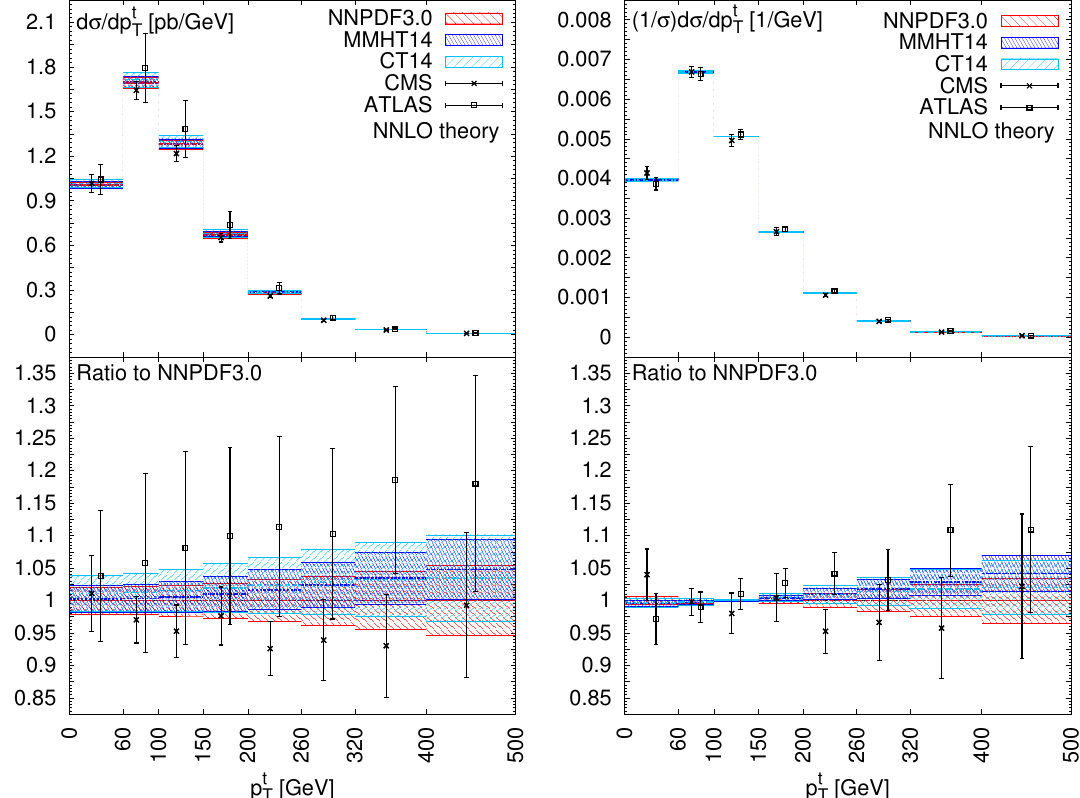
Figure 5 . Comparison between the NNLO predictions for the absolute (left) and normalized (right) p t di(cid:11)erential distributions in top-quark pair production and the corresponding CMS and ATLAS T measurements. The theoretical predictions have been computed with the NNPDF3.0, CT14 and MMHT14 sets and include only the 1{ (cid:27) PDF uncertainties, while scale uncertainties are not shown. In the lower panels, we display the same results now as the ratio to the central NNPDF3.0